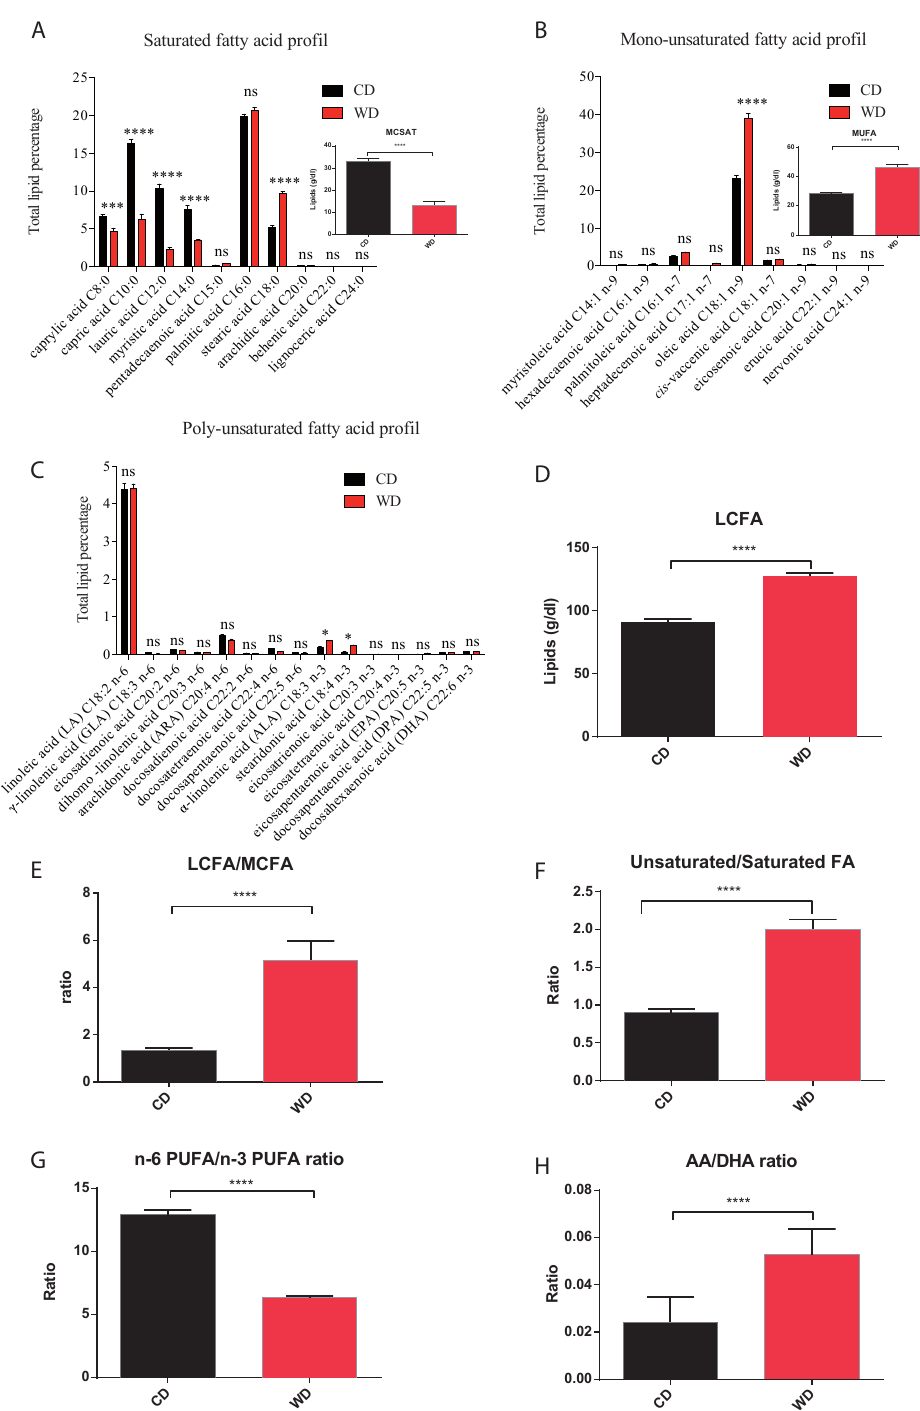
Figure 4. Milk profiles of total saturated ( A ), mono-unsaturated ( B ) and poly-unsaturated ( C ) fatty acids with total content in medium chain saturated and in mono-unsaturated fatty acids presented in miniature ( A , B ). Total content of long chain fatty acids ( D ) and long-chain / medium-chain fatty acids ( E ), unsaturated / saturated fatty acids ( F ), n-6 PUFA / n-3 PUFA ( G ) and AA / DHA ( H ) ratios at day 20 of lactation. AA: Arachidonic acid; DHA: Docosahexaenoic acid; MCSAT: Medium chain saturated fatty acids (C8:0 to C12:0); MUFA: monounsaturated fatty acid; LCFA: Long-chain fatty acid that contains at least 16 carbons; MCFA: Medium-chain fatty acid that contains less than 16 carbons. Values of p -values (assessed by Mann–Whitney U test) between “western diet” and “control diet” groups were reported with *, ***, or ****, significantly di ff erent; p < 0.05, p < 0.001 or p < 0.0001, respectively and “ns” for no